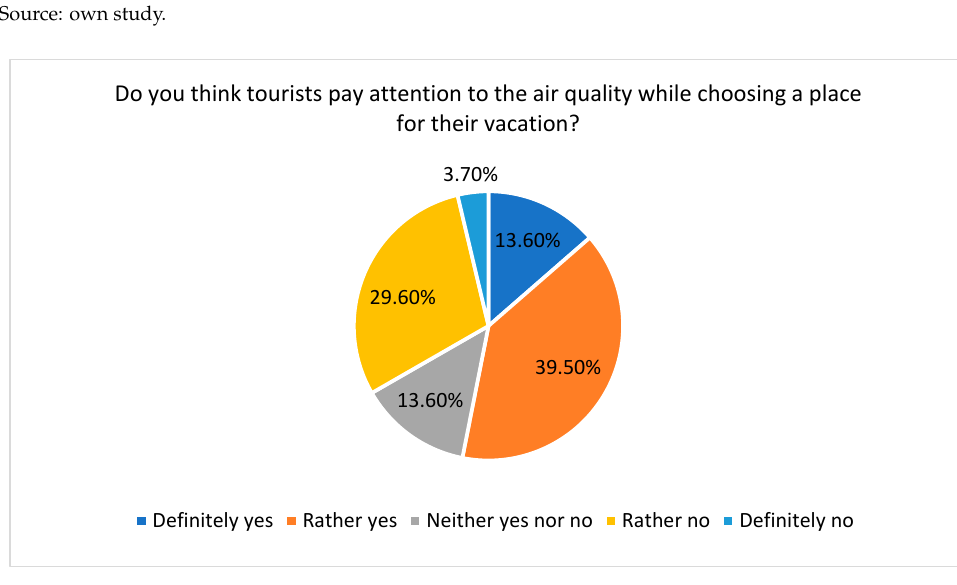
Figure 12. Tourists’ sensitivities to air quality while choosing a vacation destination. Source: own study.